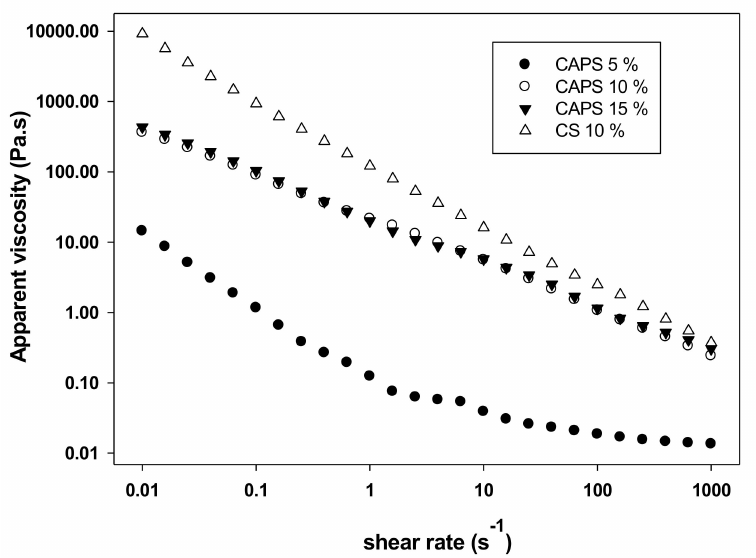
Figure 1. Steady shear viscosity of Ceiba aesculifolia subsp. parvifolia tuber starch (CAPS) and corn starch (CS).